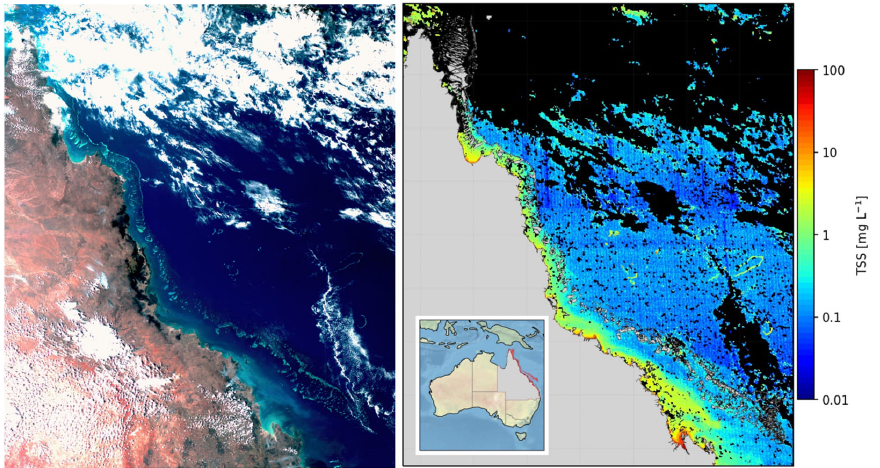
Figure 6. Near ‐ true colour Himawari ‐ 8 imagery of the GBR acquired on 27 October 2017 at 15:00 AEST ( left panel ) and the associated TSS product [mg L − 1 ] ( right panel ). Pixels masked in black due to clouds and out-of-range